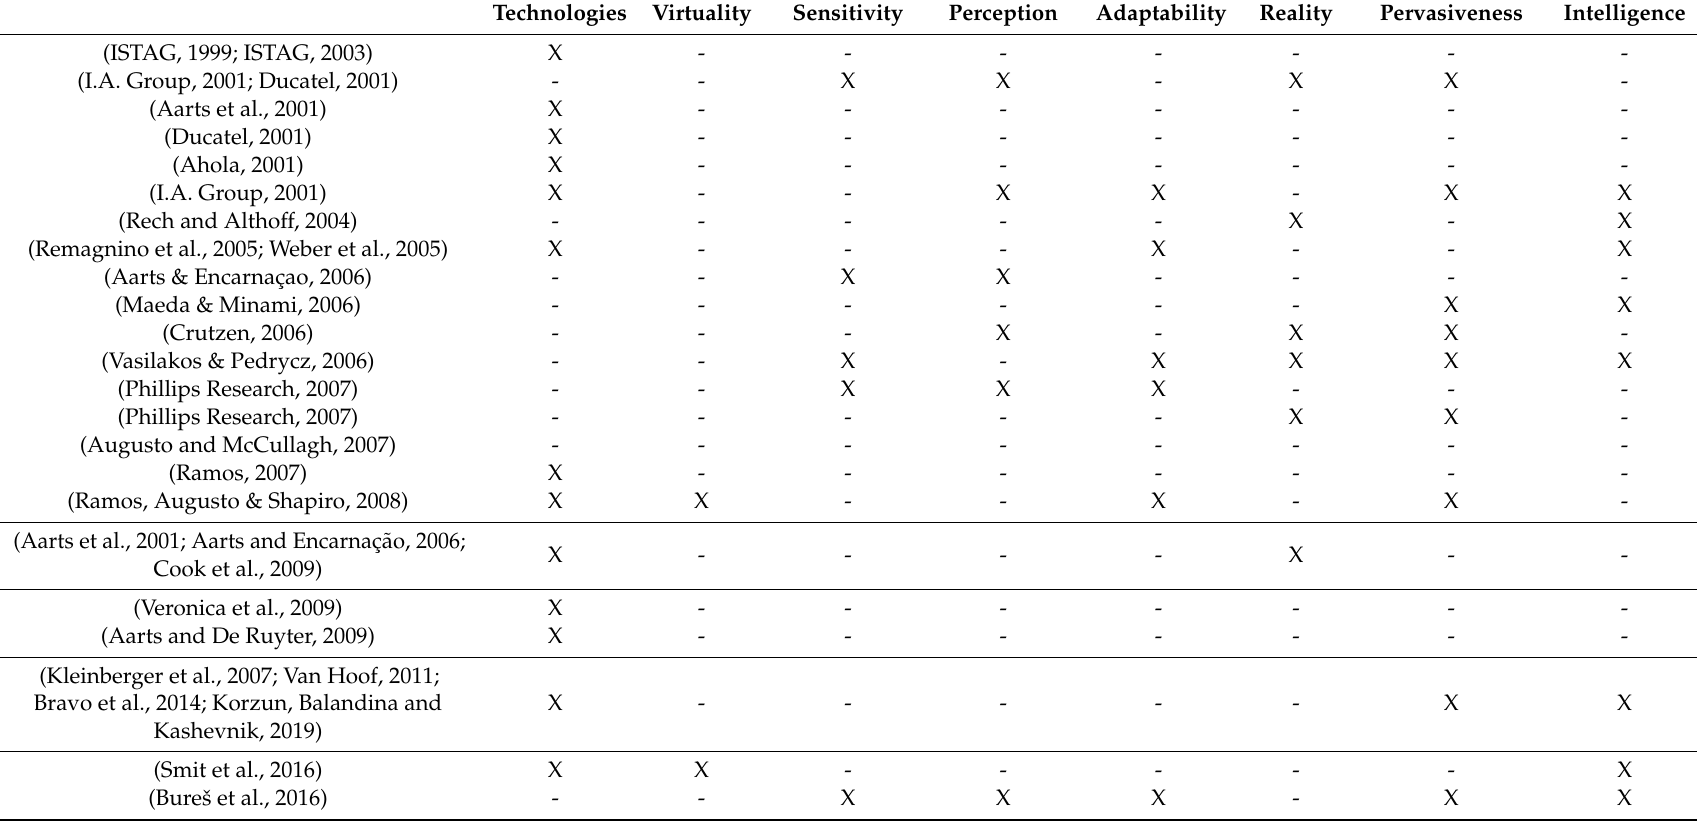
Table 1. The main features of ambient